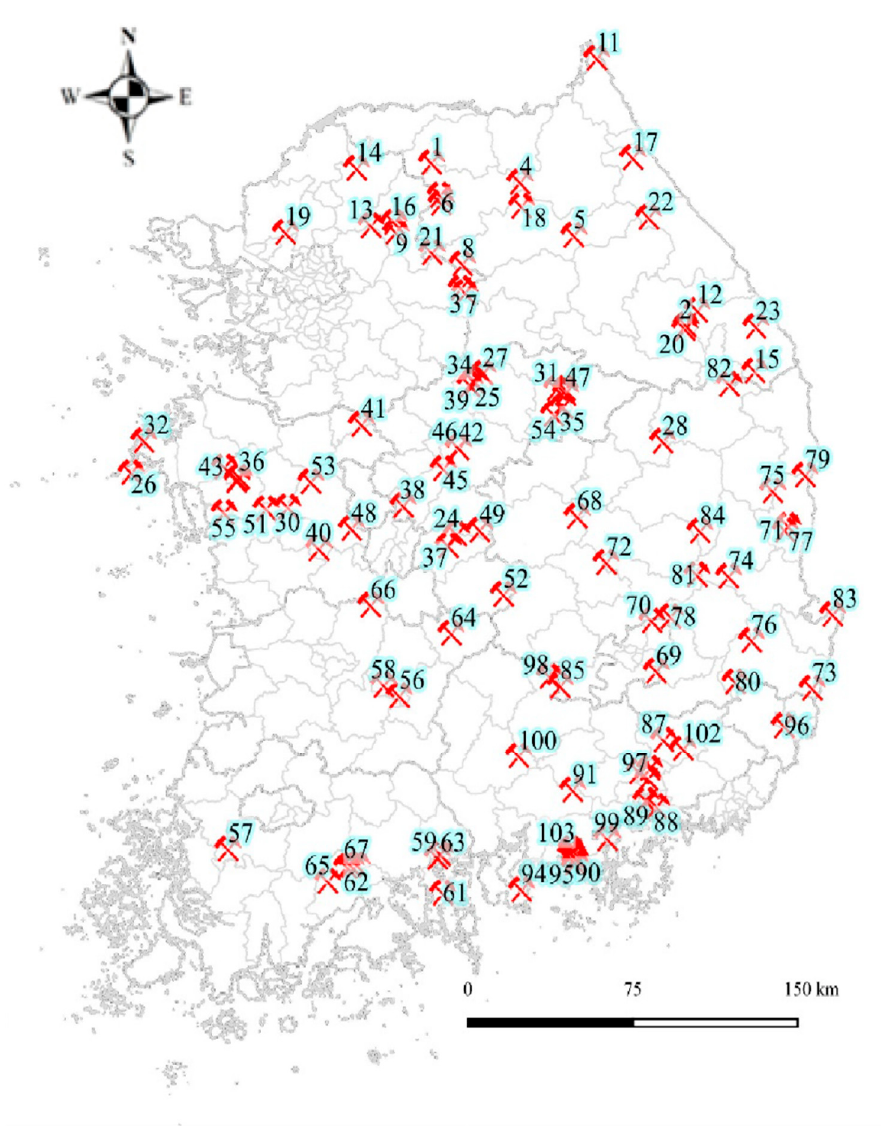
Figure 1. Location of the 103 abandoned metal